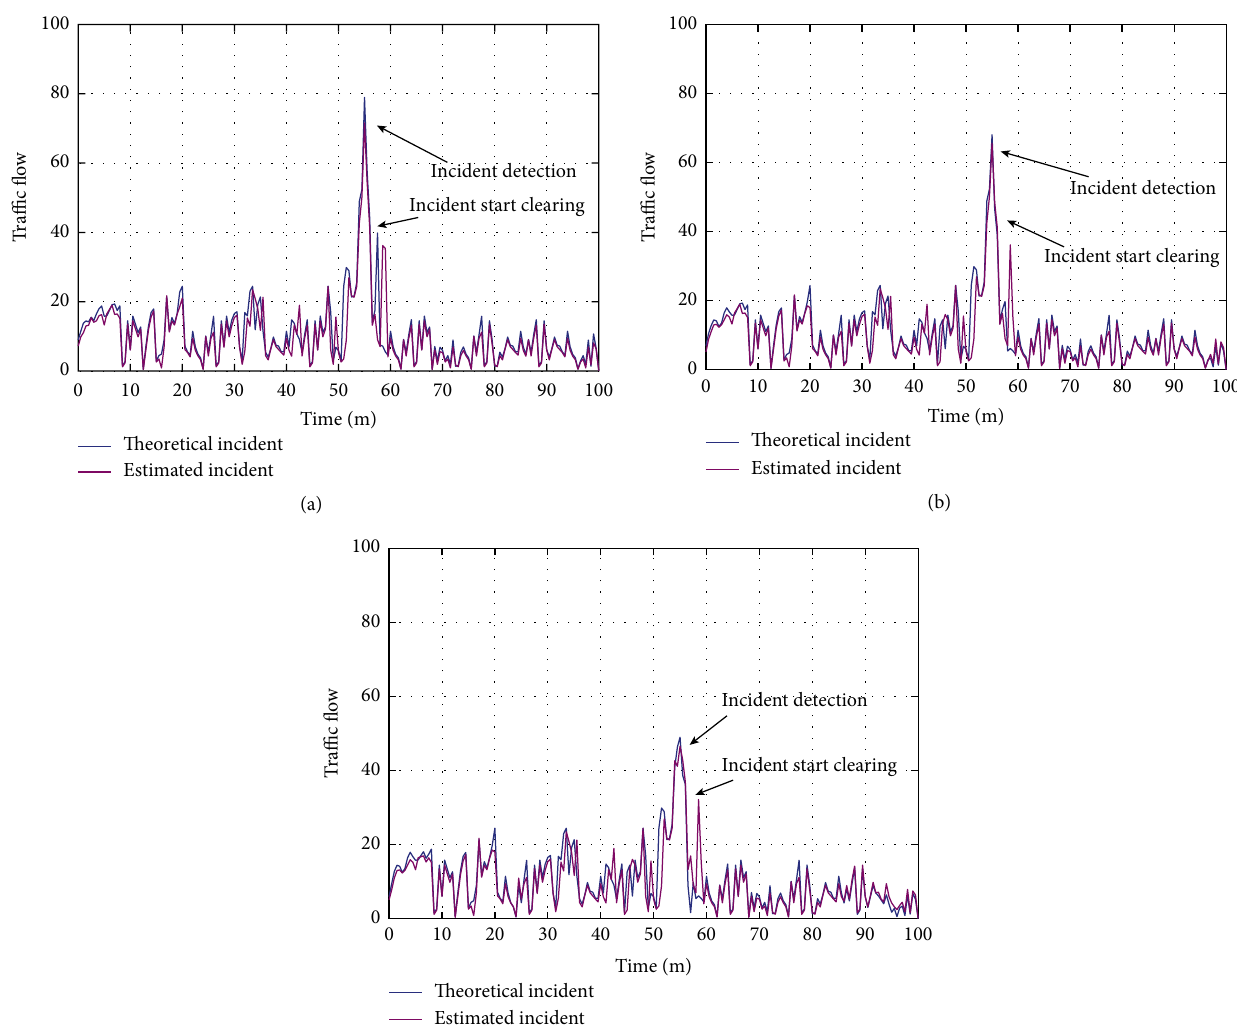
Figure 7: Comparison of the theoretical incident and estimated incident with three different cases. (a) Low traffic flow, (b) moderate traffic flow, and (c) heavy traffic